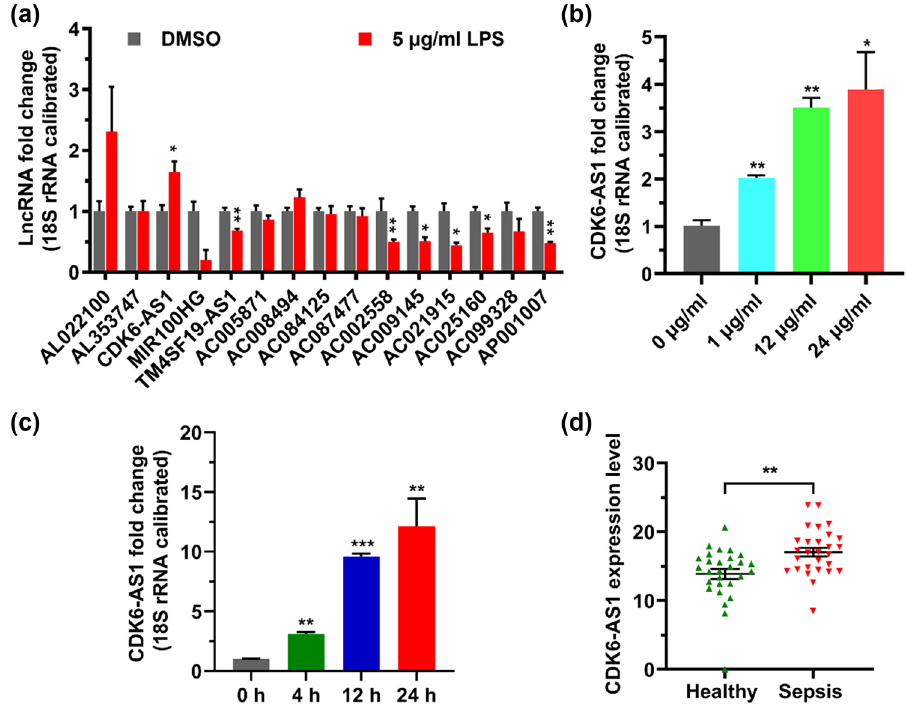
Figure 1: E ff ect of LPS on CDK6 - AS1 expression: ( a ) e ff ect of LPS on lncRNA expression, ( b ) CDK6 - AS1 level in cells exposed to di ff erent LPS concentrations, ( c ) CDK6 - AS1 level in cells after LPS treatment for various times, and ( d ) expression levels of CDK6 - AS1 in blood. * P < 0.05, ** P < 0.01, *** P <